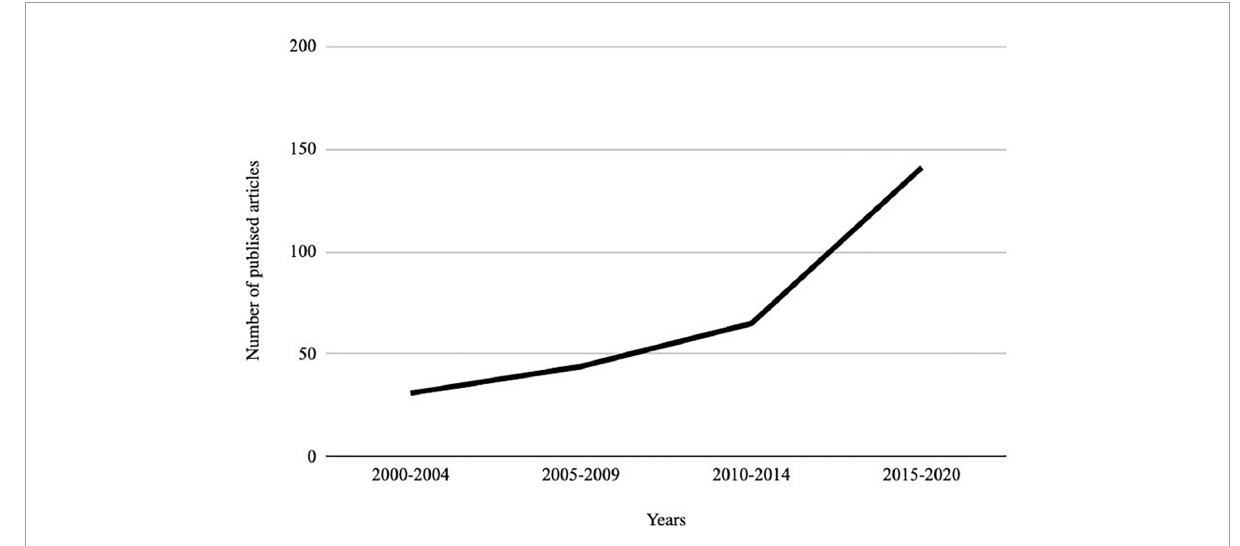
FIGURE2 Evolution of the publication of articles on loneliness and disability from